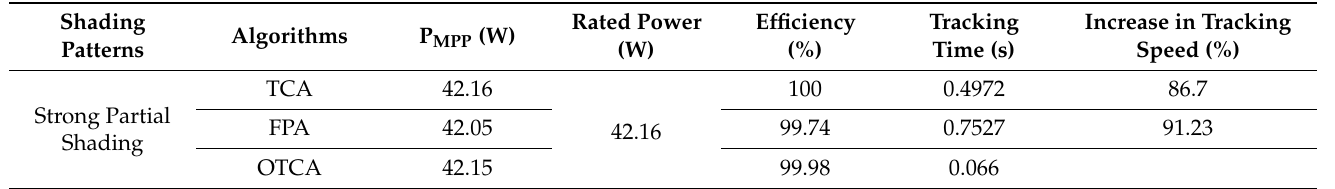
Table 5. Performance comparison of FPA, TCA, and OTCA under strong partial